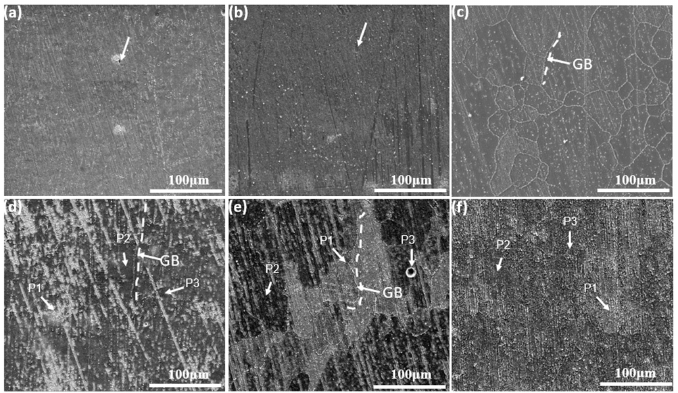
Figure 7. Surface morphology of alloys after oxidation at 700 °C for 4 and 100 h: ( a,d ) 0 ° sample; ( b,e ) 55 ° sample; ( c,f ) 90 ° sample. 55 ◦ sample; ( c,f ) 90 ◦